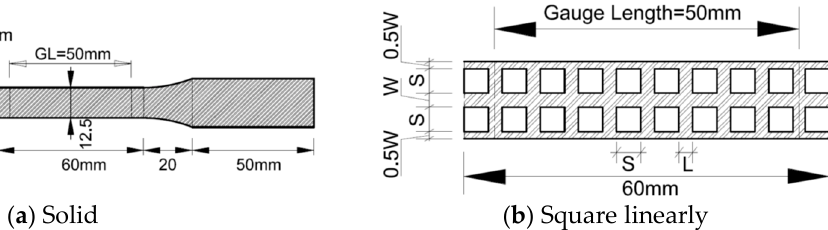
Figure 3. Experimental test specimens of the steel sheet.